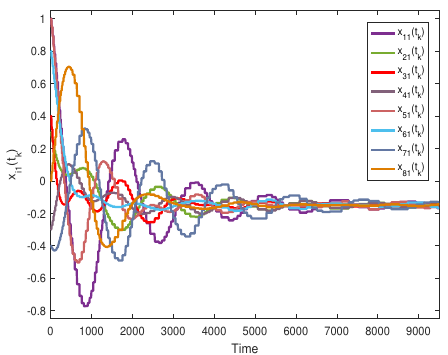
Figure 15. The trajectories of x i 1 ( t k )